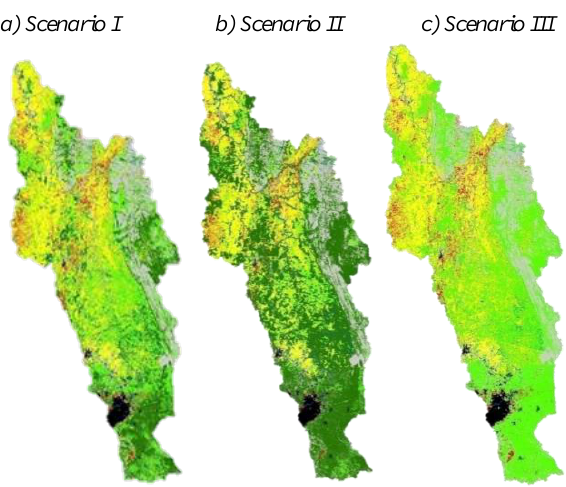
Figure 4. a and b) Reforestation Scenarios (Scenarios I and II, respectively); c) Deforestation Scenario (Scenario III)